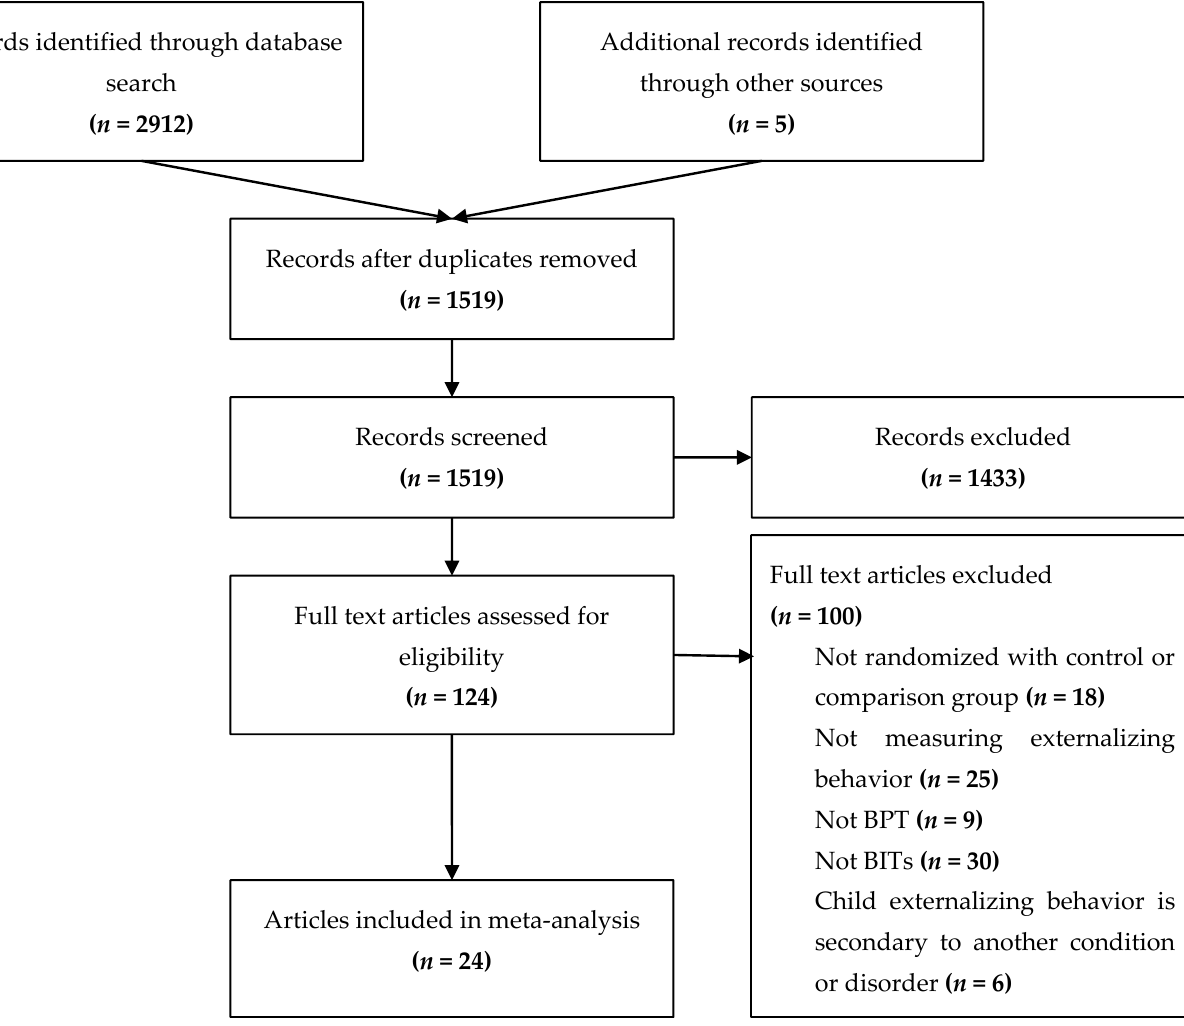
Figure 1. Selection process of articles.